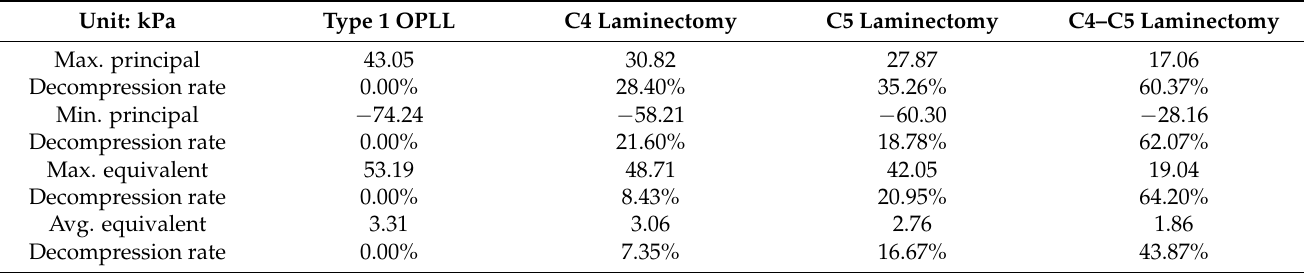
Figure 9. Neutral laminectomy simulation: ( a ) maximum and minimum principal stresses (kPa); and ( b ) maximum and average equivalent stresses (kPa). Table 4. Neutral laminectomy simulation spinal cord stresses: type 1 OPLL.